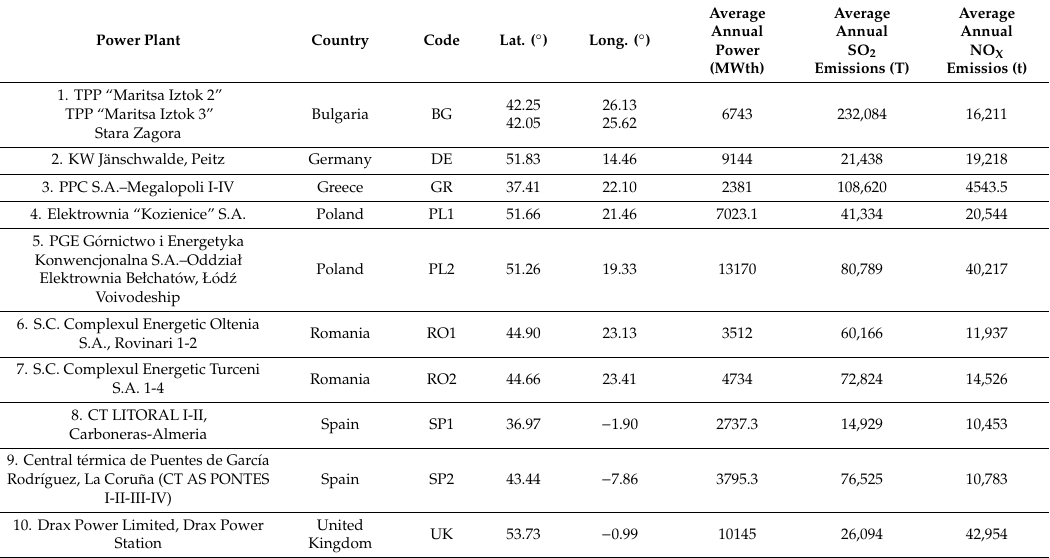
Figure 2. The spatial distribution of LCPs; these are identified by the corresponding numbers in Table 1. Table 1. Information for individual power plants (source: EEA